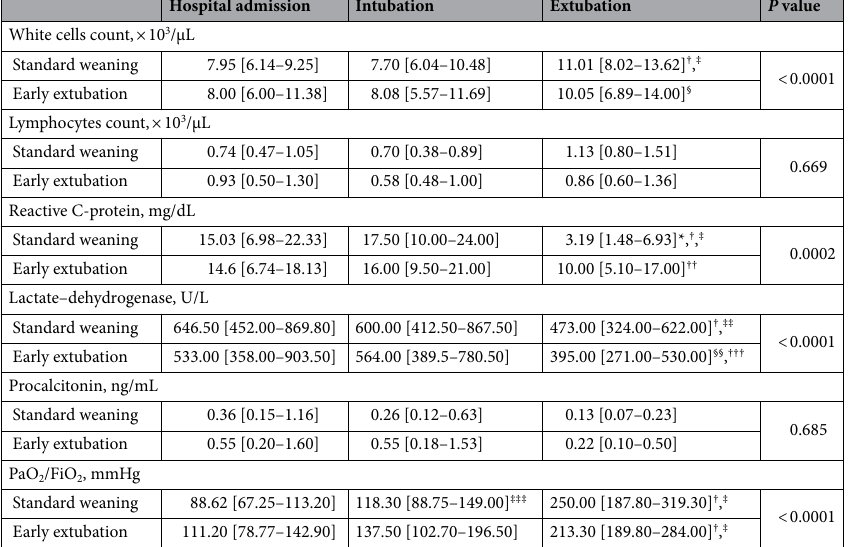
Table 4. Blood tests at hospital admission and in course of intensive care unit stay. Data are presented as median and [interquartile range]. PaO 2 /FiO 2 , arterial oxygen tension to inspired oxygen fraction ratio. P values refer to weaning category-time interactions from Satterthwaite’s analysis of variance whereas symbols refer to P values from post hoc Tukey method for comparison: * P = 0.0003 conventional weaning versus early extubation; † P < 0.0001 extubation versus hospital admission; ‡ P ≤ 0.0001 extubation versus intubation; § P = 0.031 extubation versus intubation; †† P = 0.020, extubation versus intubation; ‡‡ P = 0.0005, extubation versus intubation; §§ P = 0.012 extubation versus hospital admission; ††† P = 0.001, extubation versus intubation; ‡‡‡ P = 0.029 intubation versus hospital